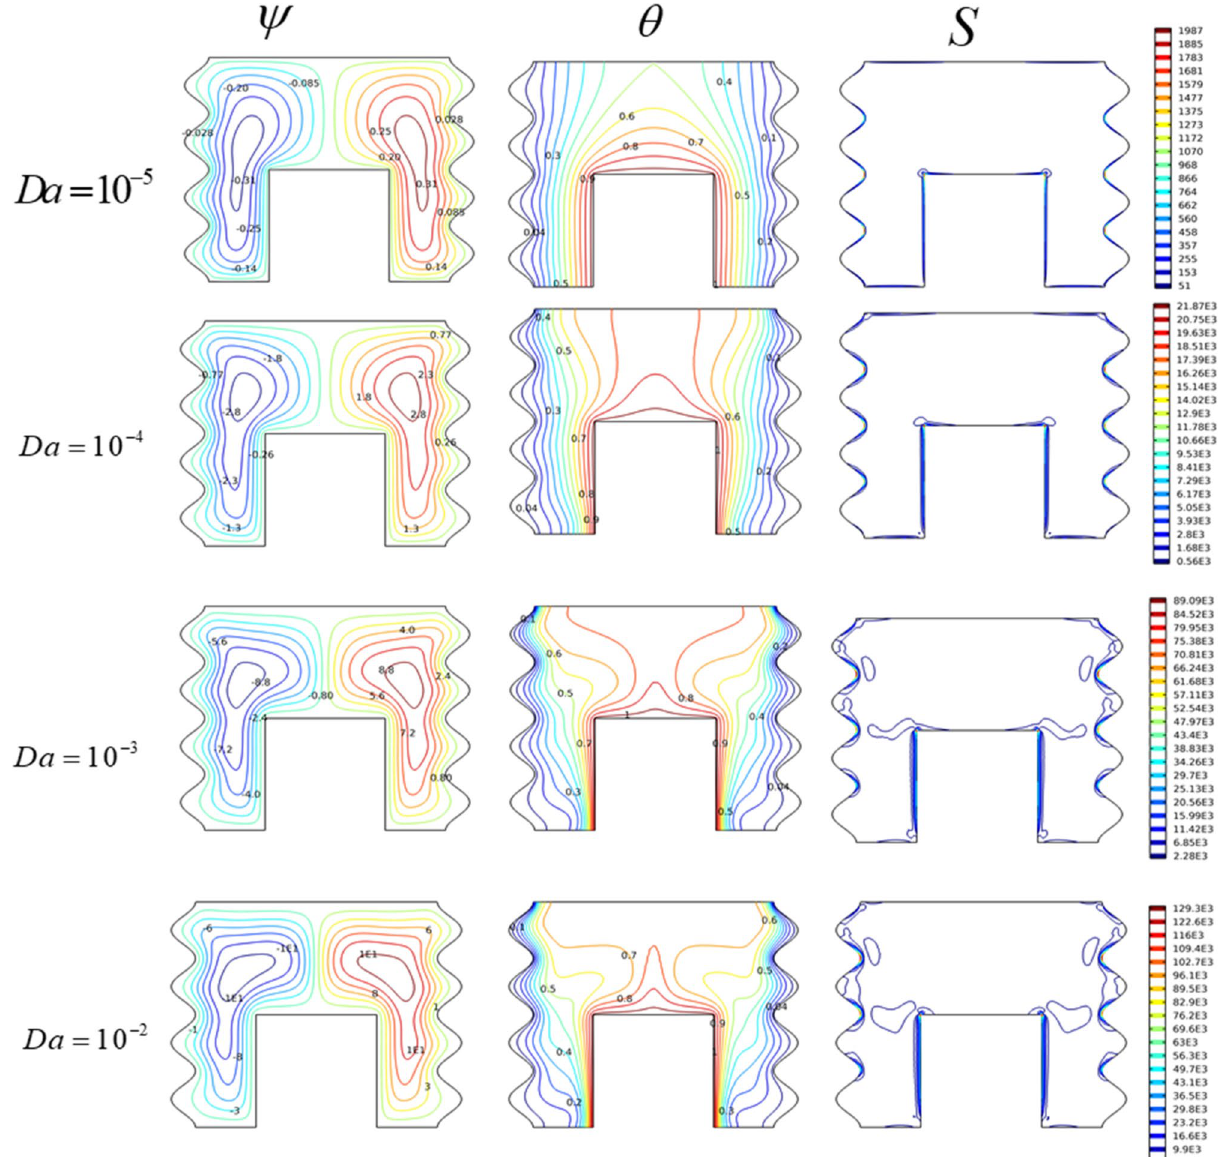
Figure 5. The impact of Da on (ψ) Streamlines, (θ) Isotherms, and (S) Entropy for Ha = 0, Ra = 10 6